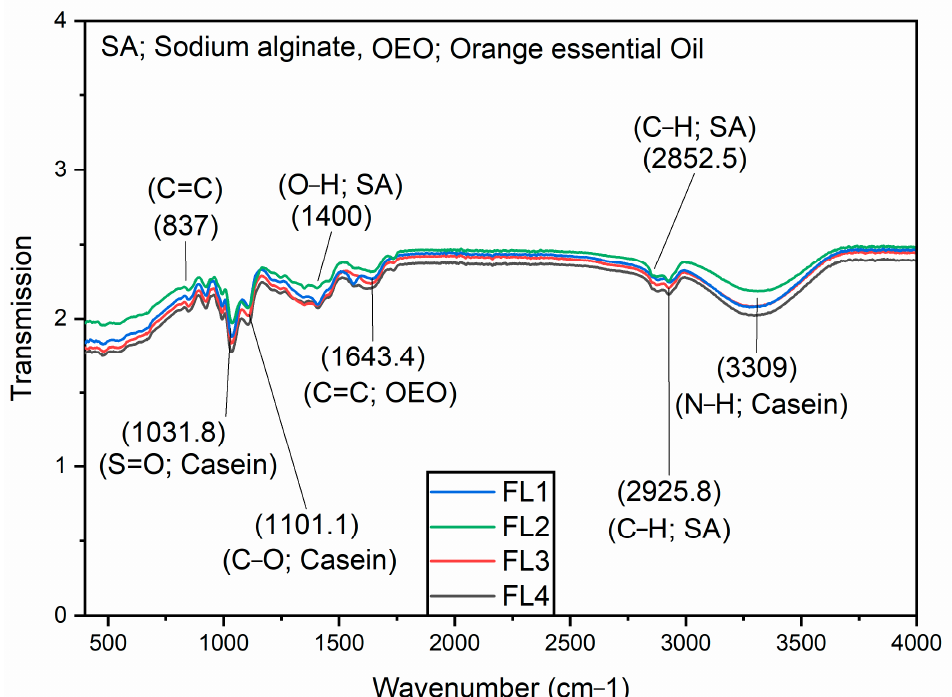
Figure 3. FTIR analysis of FL1–FL4 composite films samples: control or FL1 (CA + SA); FL2: CA + SA + OEO (1.5% v/v); FL3: CA + SA + OEO (2 % v/v); FL4: CA + SA + OEO (2.5% v/v).